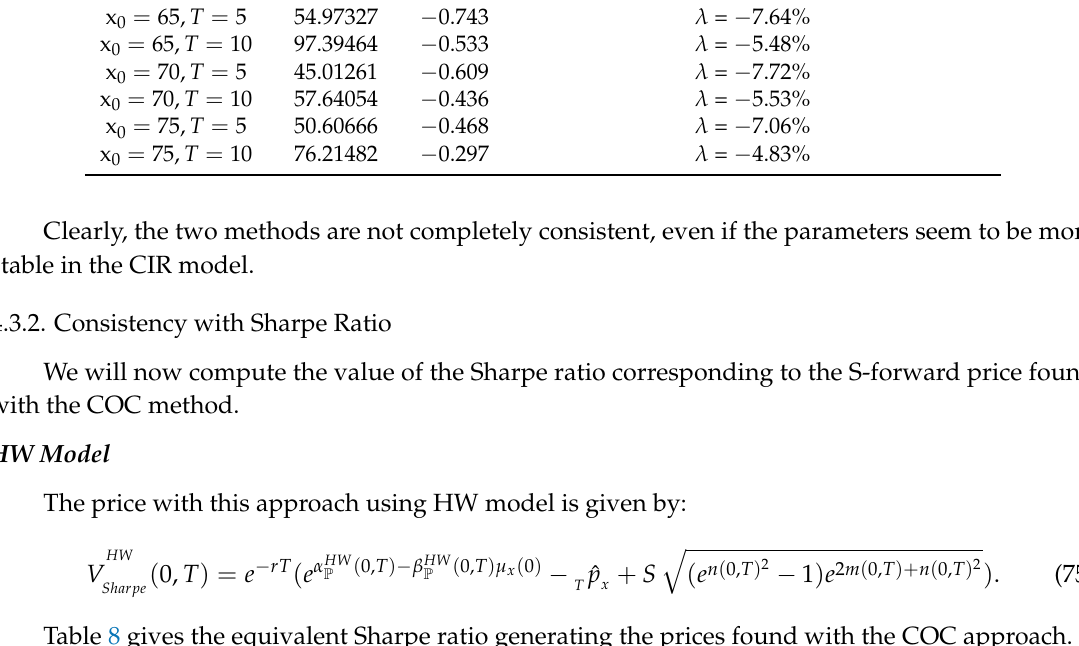
Table 7. Equivalent market price of longevity risk in the risk-neutral approach, CIR model. S-Forward COC Price κ Market Price of Longevity Risk λ = κ